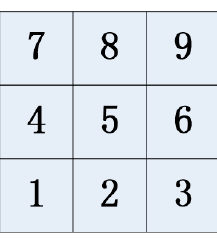
Figure 4. Schematic diagram of a three-by-three moving window